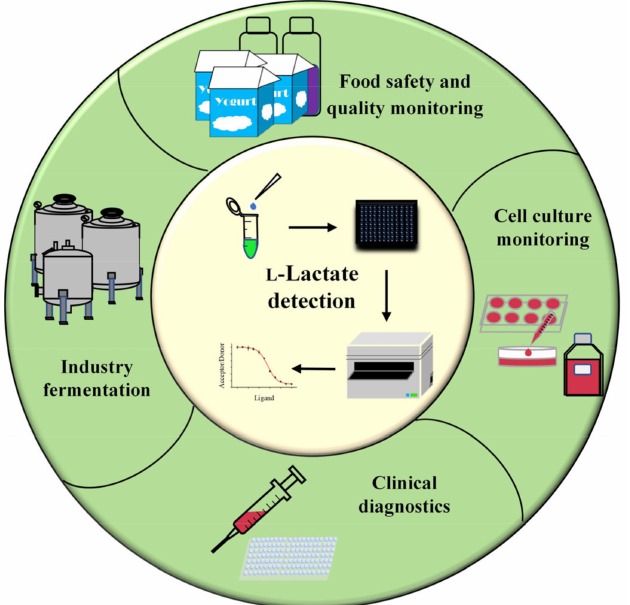
Figure 6. Schematic of the detection and application of FILLac 10N0C . The L -lactate concentration in different biological samples can be quantified by mixing the FILLac 10N0C with microvolume samples in black 96-well microplates and detected by a fluorescence microplate detector. The FILLac 10N0C may be widely used in the fields of food safety and quality control, industry fermentation, clinical diagnostics, and cell culture